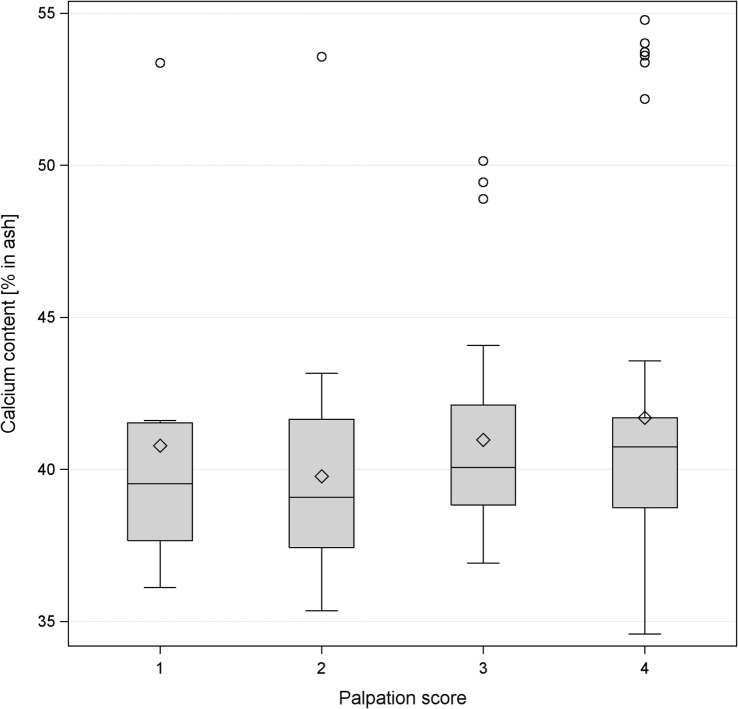
Boxplot of the levels of percentage of calcium content in the keel bone and palpation score of the same bone. The horizontal line shows the median, and the diamonds show the mean. The levels of calcium content were classified as follows: level 1 <38%, level 2 38–40.36%, level 3 40.37–42%, level 4 >42%.